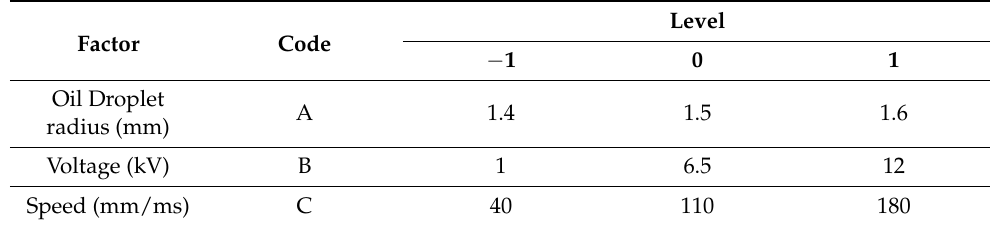
Table 3. Response surface test factor level coding